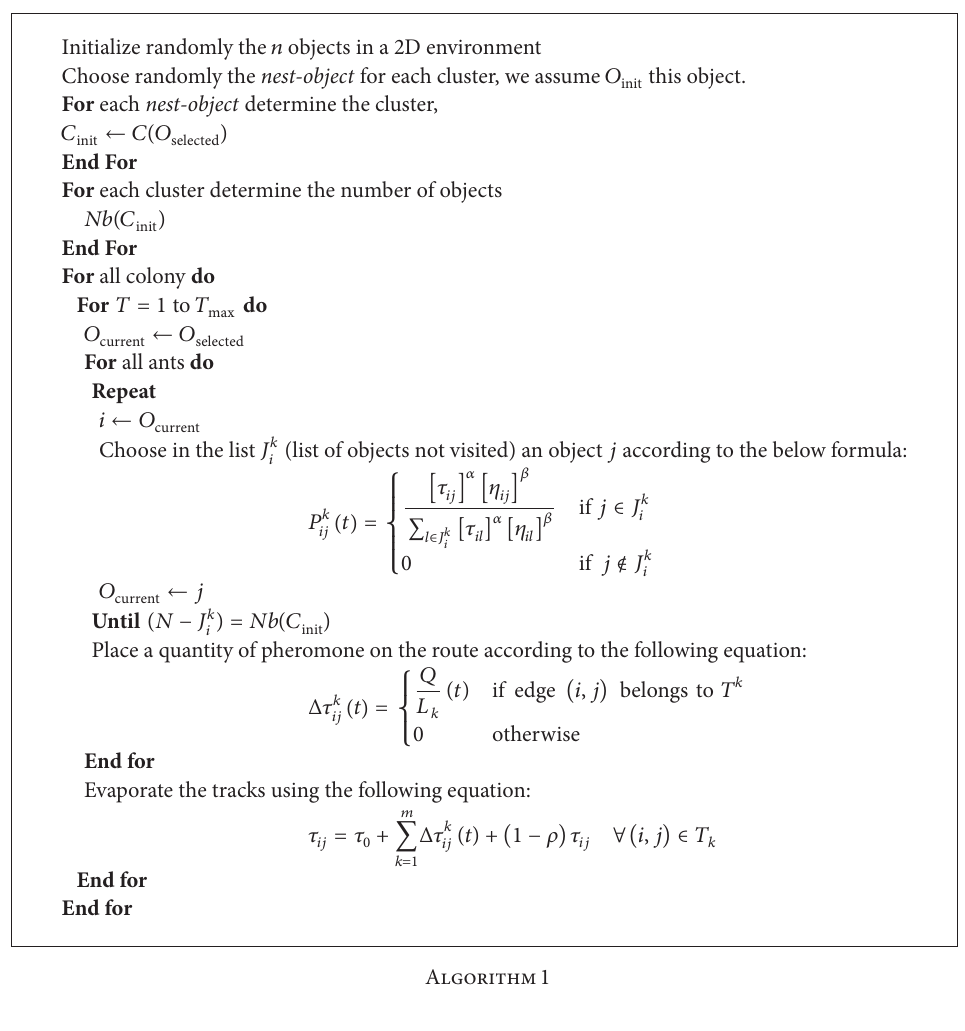
Table 1: Hybrid ASClass 𝑖 algorithms.